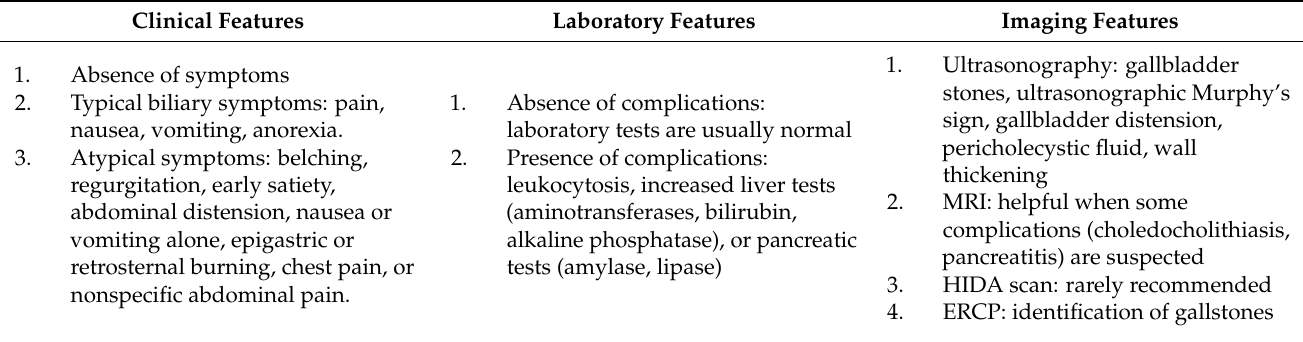
Table 8. Diagnosis of cholelithiasis in pregnancy. Data from Ref